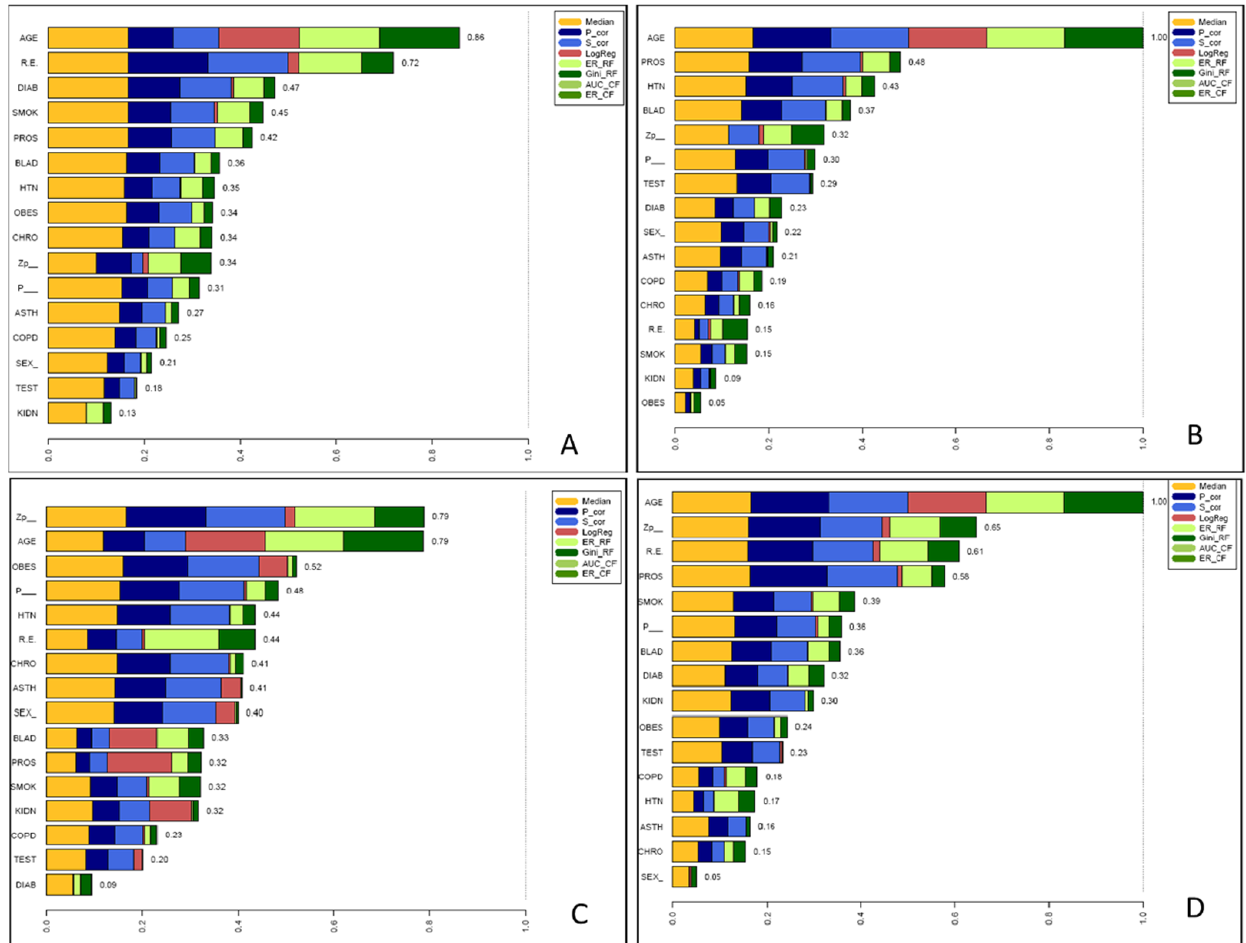
(68% vs. 65.3%), intubation (11.3% vs. 8.4%) and death (23.7% vs. 16.8%) were higher amongst ever smokers, these were not significant. Figure 2 outlines the results of EFS analysis, where age, race/ethnicity, diabetes, current/former smoker and prostate cancer diagnosis were the top five features selected as the most parsimonious, and biologically reasonable model to describe the relationship between those testing positive, and the features from social, demographic and medical co-morbidities. In a similar manner, the identified features in this cohort predicting the risk of hospitalisation were: older age, prostate and bladder cancer diagnosis, hypertension, and zip code. For risk of intubation, the identified factors were zip code, age, obesity, English as the preferred 1st language, and hypertension. For risk of death, the identified factors were: age, zip code, race/ethnicity, prostate cancer, and smoking status.